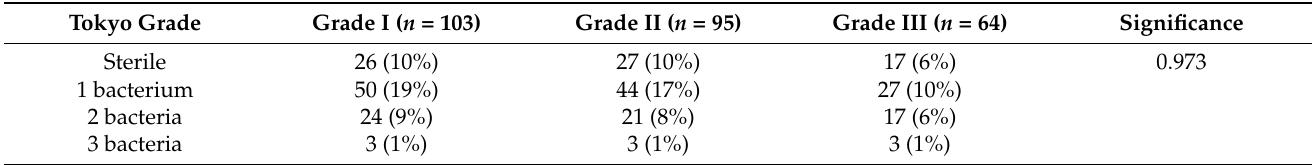
Table 3. Bacterial presence in bile according to Tokyo Guidelines.